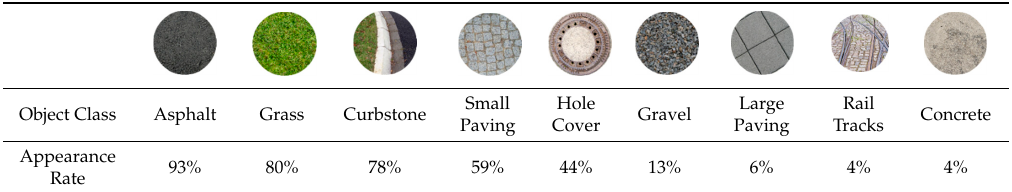
Table 1. Object classes ranked by relative pixel frequency in the manually produced segmentation masks for the training data set.